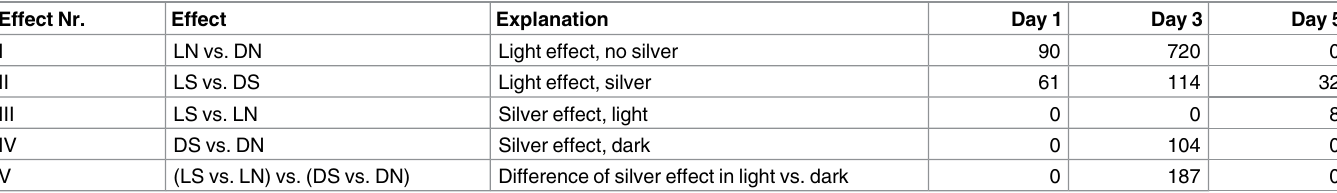
Table 1. Number of differentially expressedproteins at all time points. Effect Nr.